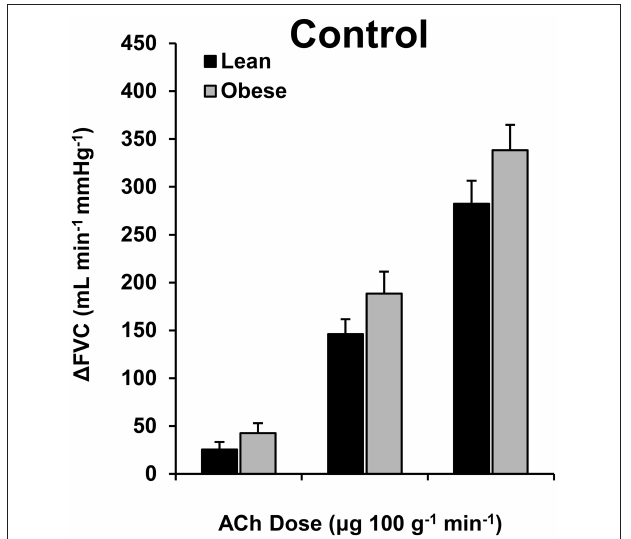
FIGURE 1 | ACh responses. Change in forearm vascular conductance ( (cid:2) FVC) with intra-arterial ACh infusion. (cid:2) FVC without inhibition was not different between lean ( n = 46 ) and obese ( n = 29 )